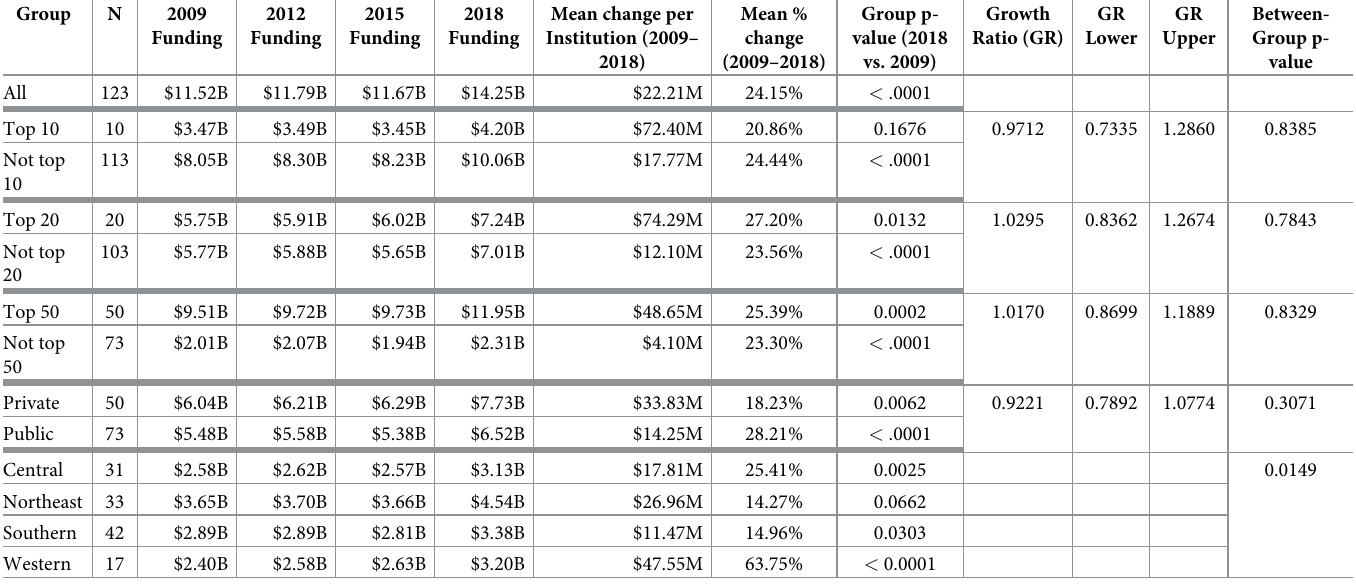
Table 1. NIH funding over time and tests for significant change within- and between-groups. Group